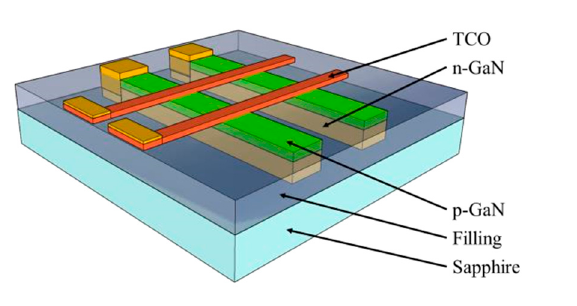
Figure 1. 3D schematic of a simplified 2 × 2 LED array based on fins etched from a planar LED wafer. Matrix-addressing of each LED pixel is obtained by n -GaN bottom contact via each fin and p -GaN crossing line contact on top of the planarized fins made of either a transparent conductive oxide (TCO) or a semitransparent thin metal